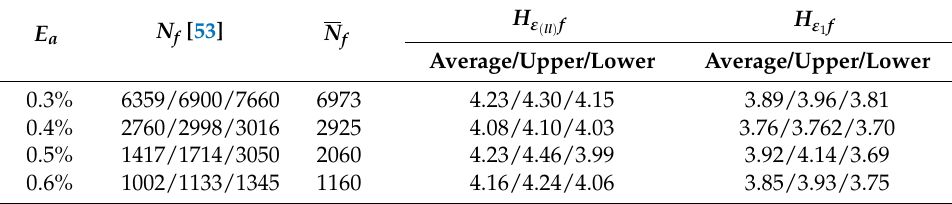
Table 7. Tested low-cycle lives of the pure copper T2 and the critical values of